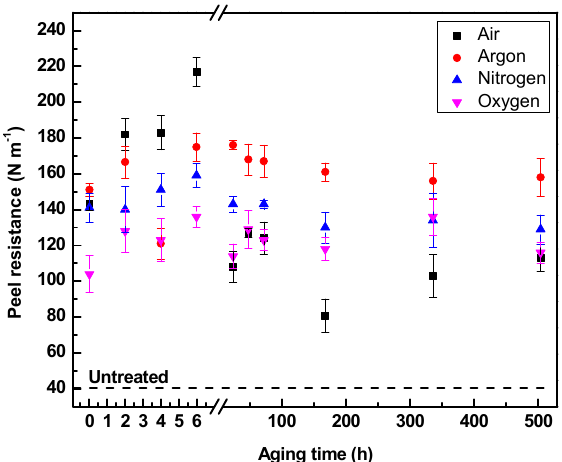
Figure 10. Peel resistance of LDPE treated for 120 s using different gases and stored in air.